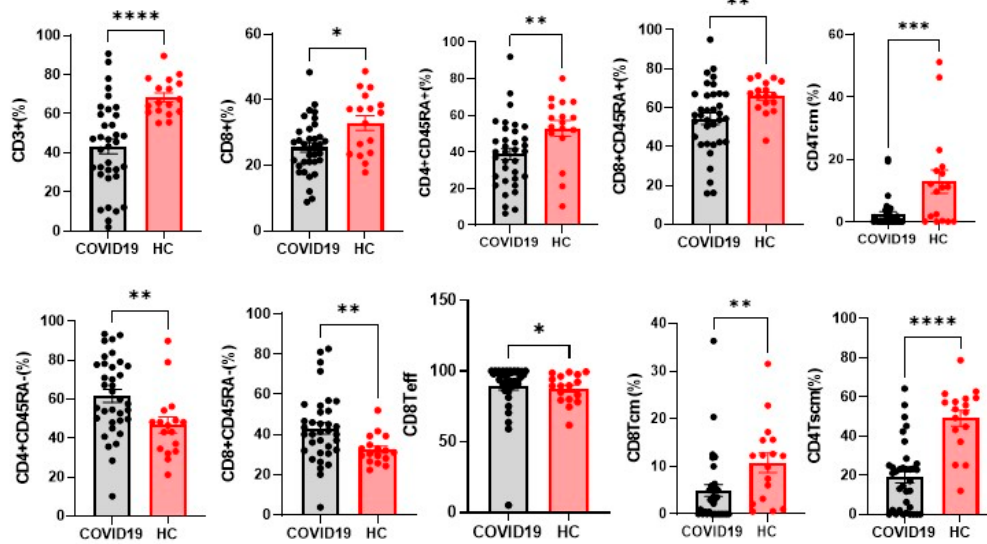
Figure 2. Alteration of immunologic features of the patients with COVI-19. Percentages of T cells from the healthy controls (n = 17), and COVID-19 (n = 35). The level of significance is indicated as follows: * p < 0.05. ** p < 0.01, *** p < 0.001, **** p < 0.0001.